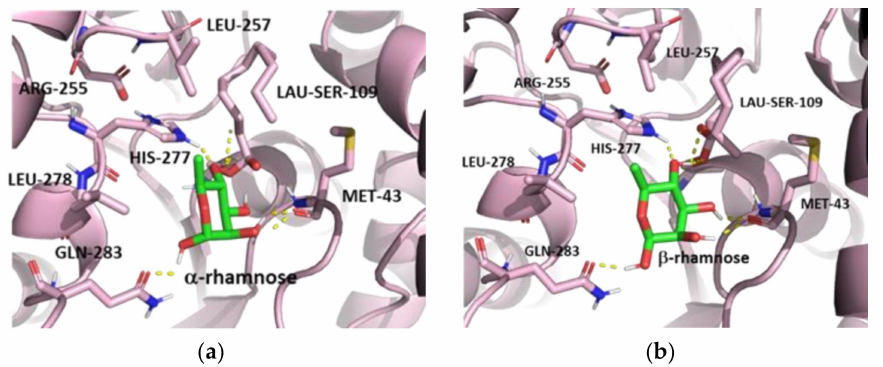
Figure 7. PSL active site with docked rhamnose: ( a ) α -rhamnose and ( b ) β -rhamnose. PSL is depicted in cartoon pink, principal residues of the enzyme are depicted in pink sticks and sugars in green sticks, hydrogen bond interactions are depicted as yellow dash